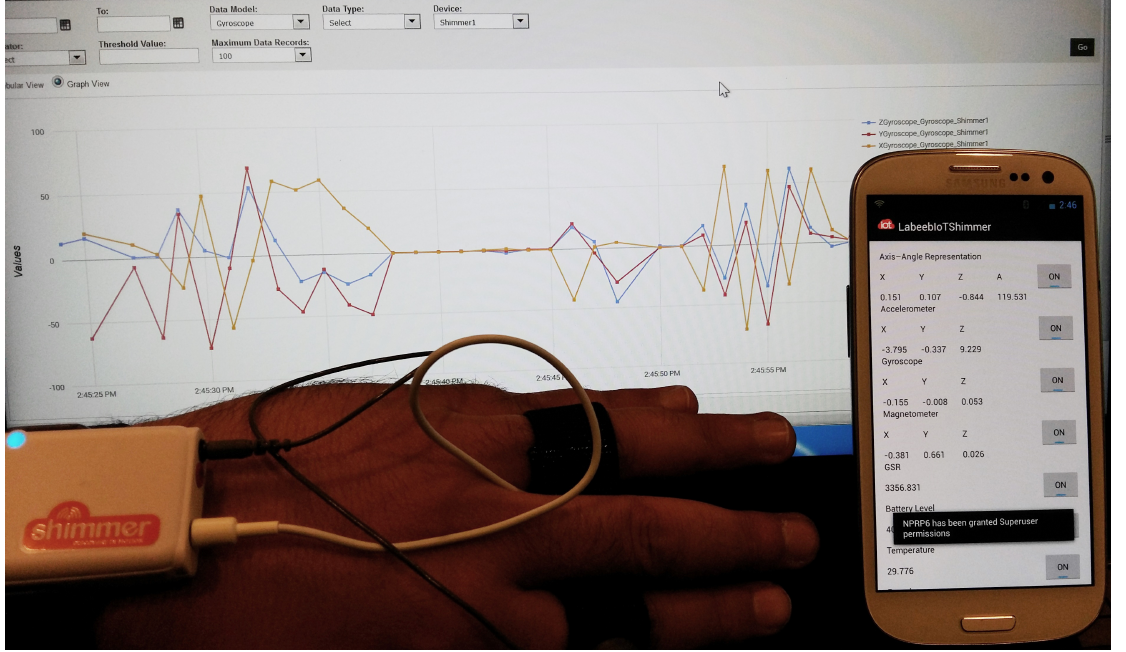
Figure 3. Real-time data collected by the ORACE-Net Mobile Device (OMD), routed through the ORACE-Net network and then displayed on the Labeeb-IoT